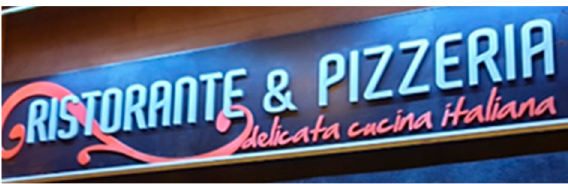
Figure 34. Almazora: Romanian-Spanish sign on a butchery.